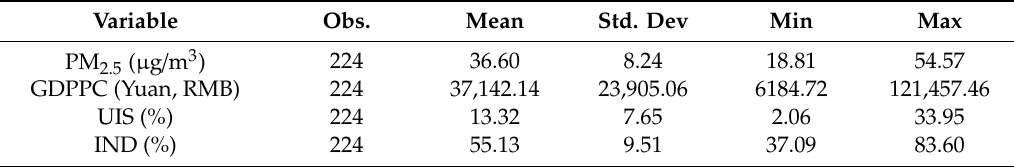
Table 1. Description of the panel data from 2000 to